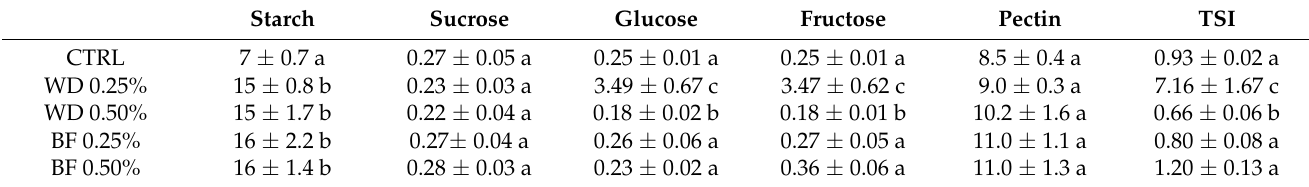
Table 2. Content of starch and soluble sugars (mg/g fw, median ± error), and total sweetness index (TSI) in lettuce leaves after four weekly foliar treatments with water (CTRL), 0.25% and 0.5% wood distillate (WD) and WD combined with 3% soy lecithin and 5% flavonoid-rich wood glycolic extract (BF). Different letters indicate statistically significant ( p < 0.05) differences between treatments. Starch Sucrose Glucose Fructose Pectin TSI CTRL 7 ± 0.7 a 0.27 ± 0.05 a 0.25 ± 0.01 a 0.25 ± 0.01 a WD 0.25%